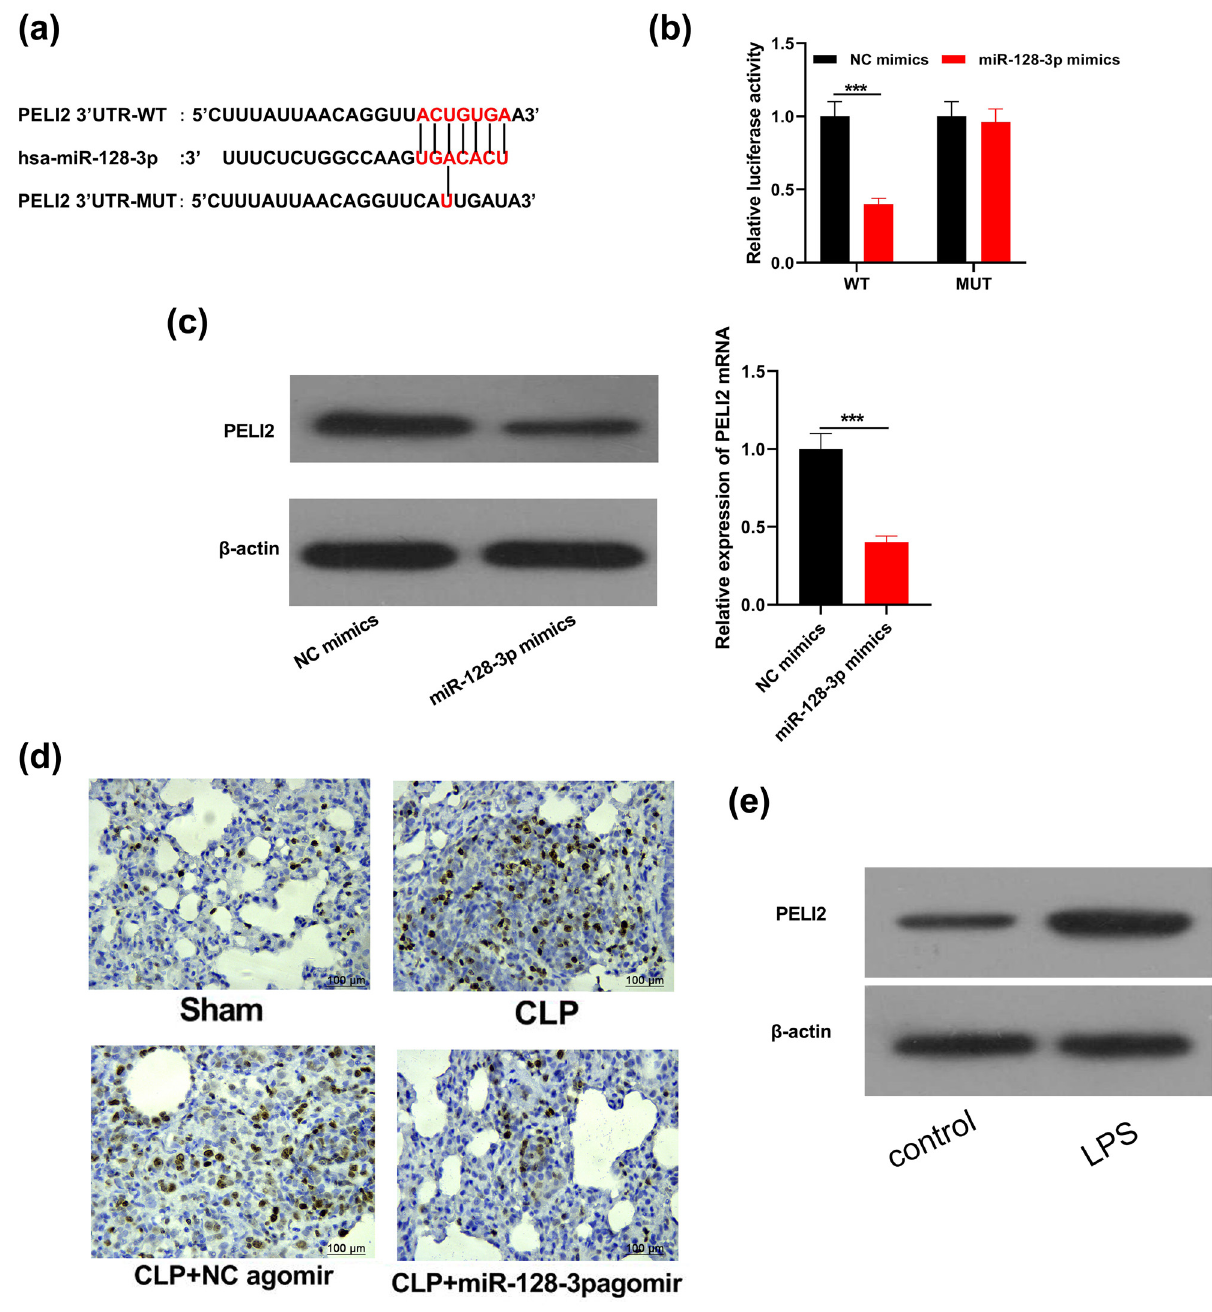
Figure 4: PELI2 is miR - 128 - 3p target. ( a ) TargetScan data recognized that miR - 128 - 3p contained conservative binding sites of PELI2. ( b ) The binding relation of PELI2 and miR - 128 - 3P was determined via assay of luciferase reporter. ( c ) Western blot plus RT - qPCR analyzed PELI2 and its mRNA level in cells that were all transfected with mimics of miR - 128 - 3p. ( d ) IHC of PELI2 expression in tissues. ( e ) Western blot analysis of PELI2. *** P <